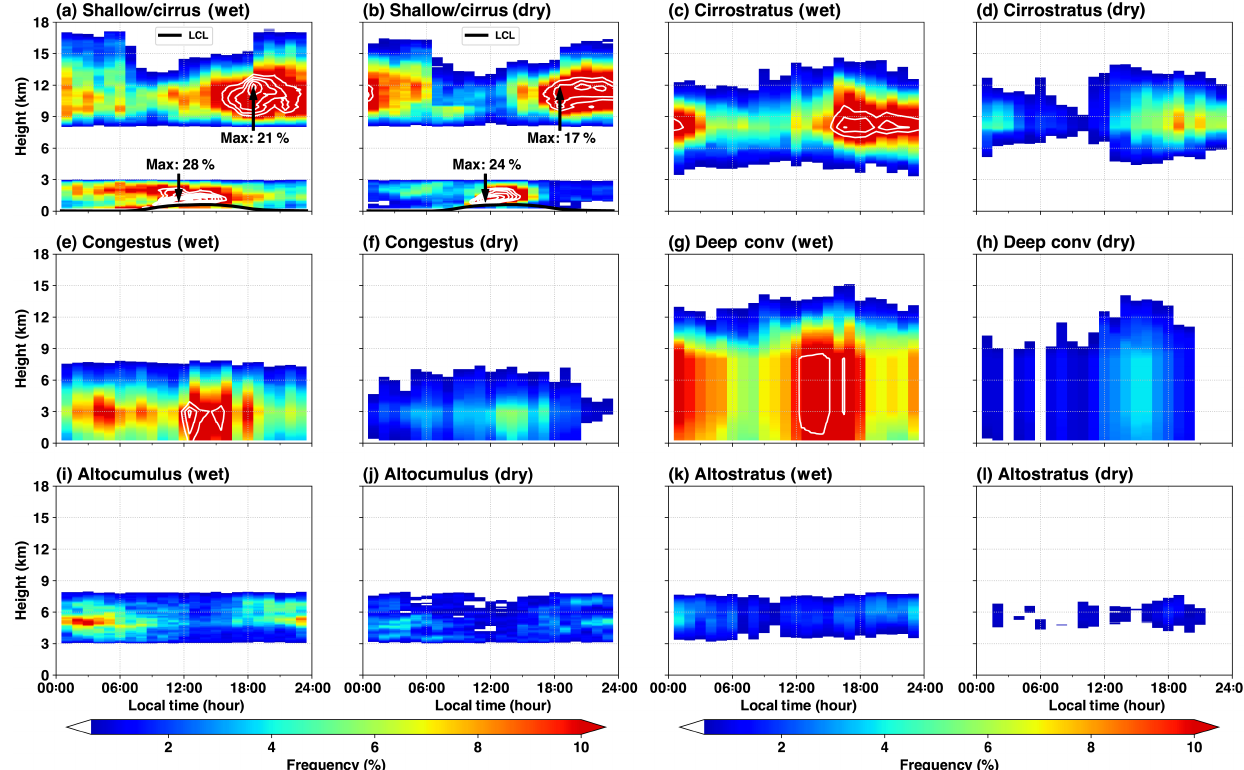
Figure 8. As in Fig. 6 but for wet season and dry season conditions.